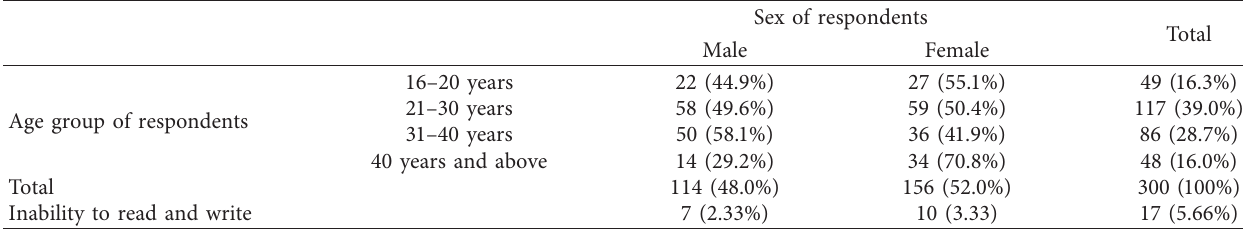
Table 1: Sociodemographic details of respondents.